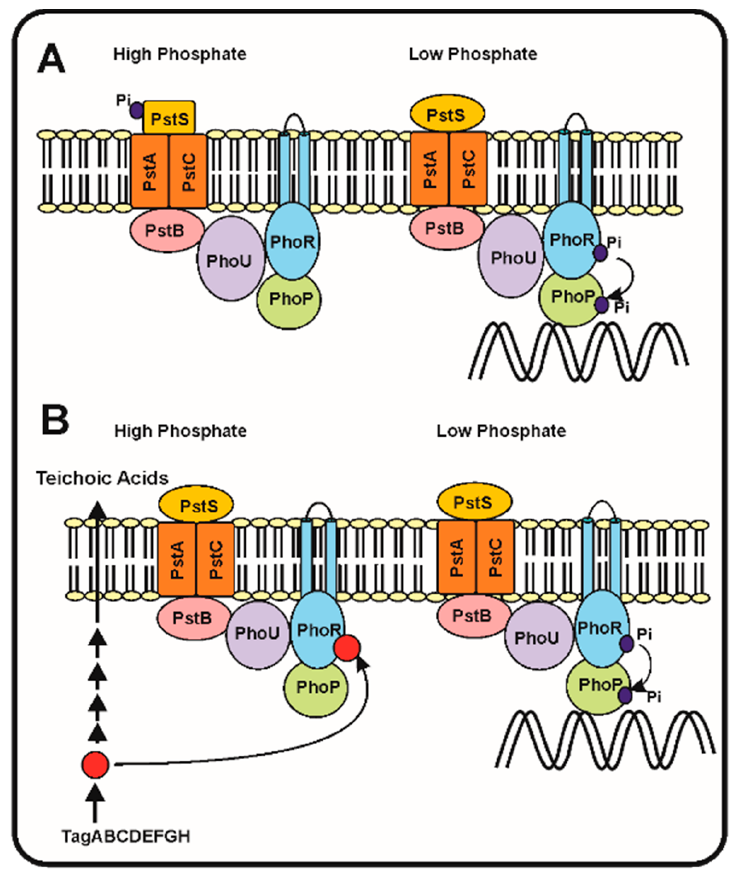
Figure 1. Phosphate transport and signalling according to the seven proteins and the teichoic acid intermediate models. ( A ) The seven proteins model of Hsieh and Wanner [39]. ( Left ) In phosphate replete conditions, the PstS protein binds phosphate and this interaction blocks the autophosphorylation of PhoR and the subsequent phosphorylation of PhoP avoiding the activation of the genes of the Pho regulon. ( Right ). When phosphate is limiting the PstS conformation